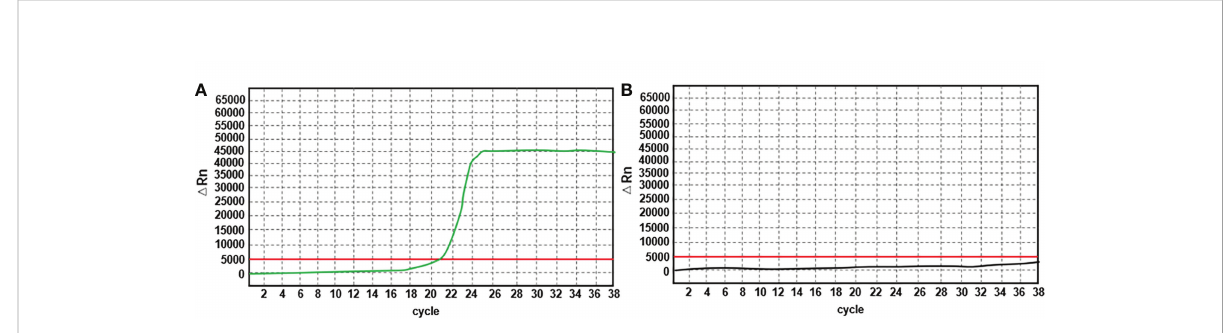
FIGURE 3 Reference graph of MLH1 methylation assay. (A) : Green line represents the fl uorescence curve of the positive reference detection target; (B) : Black line is the fl uorescence curve of the negative reference detection target; the Red line indicates the set threshold value. The horizontal coordinate represents the number of cycles and the vertical coordinate represents the signal